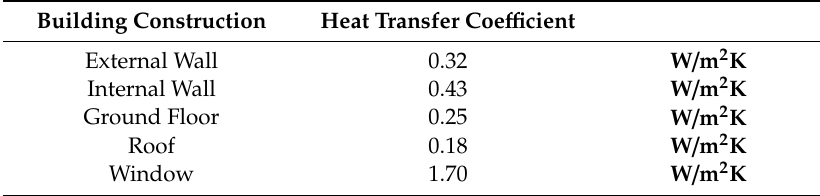
Table 2. Heat transfer coe ffi cient